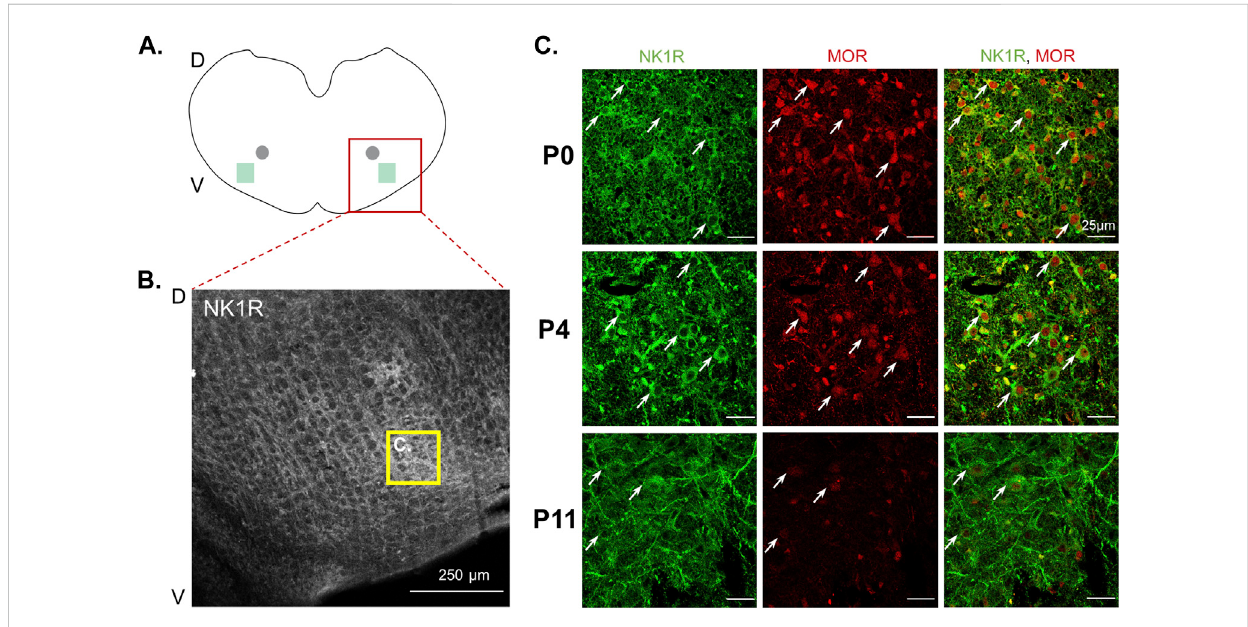
FIGURE 4 Mu-opioid receptor expression decreased in neonatal preBötzinger complex NK1R + neurons during postnatal development. Schematic of transverse medullary slices (A) highlights the preBötzinger Complex (preBötC, green square) located lateral and ventral to the semi-compact nucleus ambiguous (gray circle). Representative confocal images [ (B) , 10x] identify neurokinin-1 receptor positive (NK1R+) neurons in the preBötC (yellow box). Representative confocal images [ (C) , 40x] demonstrate NK1R + preBötC neurons (green) express mu-opioid receptors (MOR) at all ages; however, P0 neonates appear to have the strongest expression of mu-opioid receptor in NK1R + preBötC neurons (white arrows) compared to P4 neonates and mu-opioid receptor appeared to have the lowest expression in P11 neonates ( n = 6, 3 males, 3 females per age